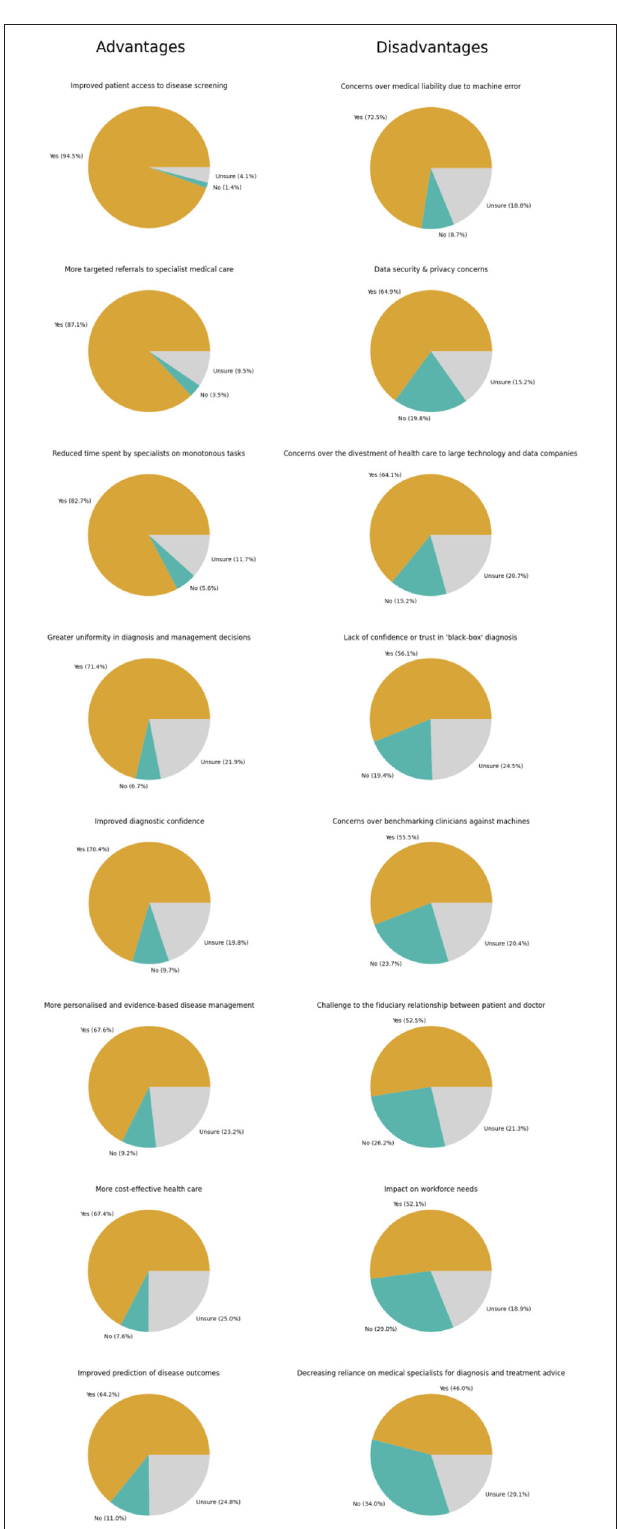
FIGURE 3 | Perceptions regarding advantages and disadvantages of artificial intelligence (AI) of ophthalmologists.